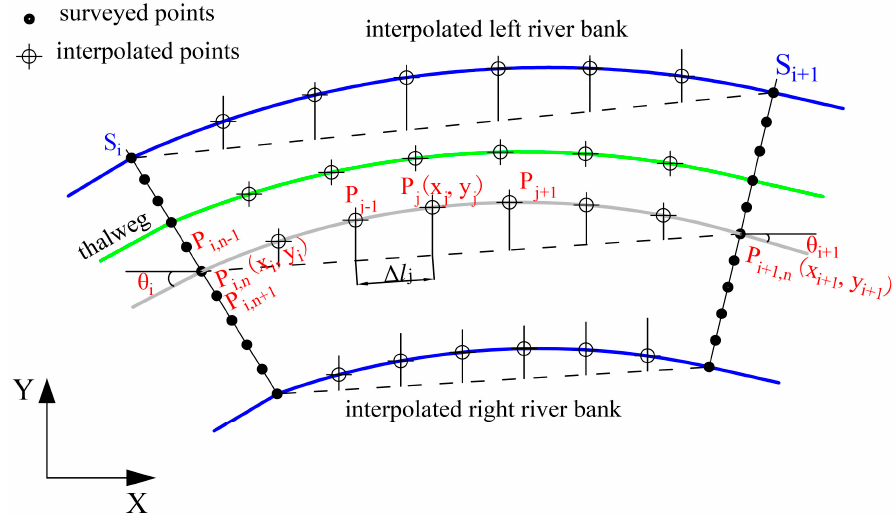
Figure 4. River channel construction using the QHSP (Quartic Hermite Spline with Parameter) method.